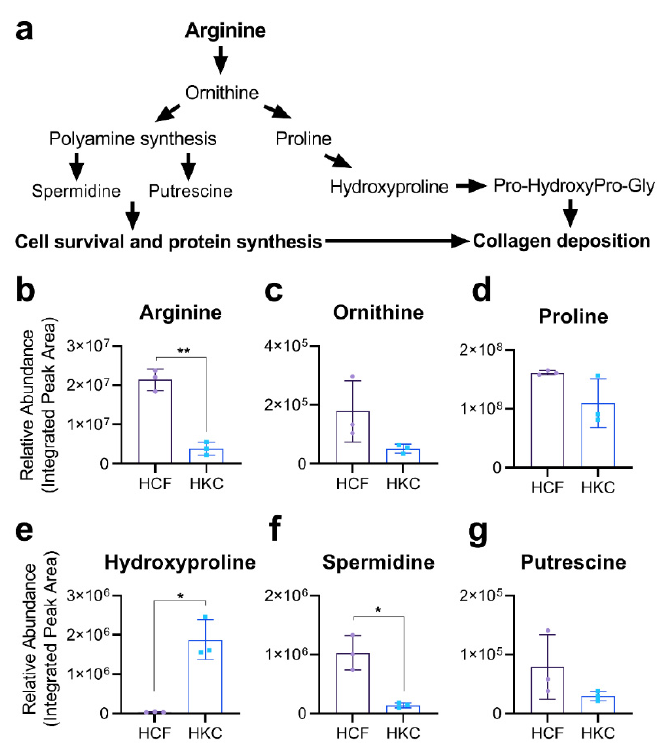
Figure 2. Arginine-related metabolite levels in HCFs and HKCs. ( a ) General schematic of arginine metabolism showing conversion of arginine to ornithine leading to either polyamine synthesis or generation of proline and hydroxyproline. ( b – g ) Metabolomics analysis of cytosolic levels of arginine-related metabolites (arginine and ornithine), collagen-related metabolites (proline and hydroxyproline), and polyamines (spermidine and putrescine) in 3D constructs of HCFs and HKCs. An unpaired, nonparametric t -test with Welch’s corrections was used to determine statistical significance with * p < 0.05 and ** p < 0.01 based on n = 3. Error bars represent standard deviation.